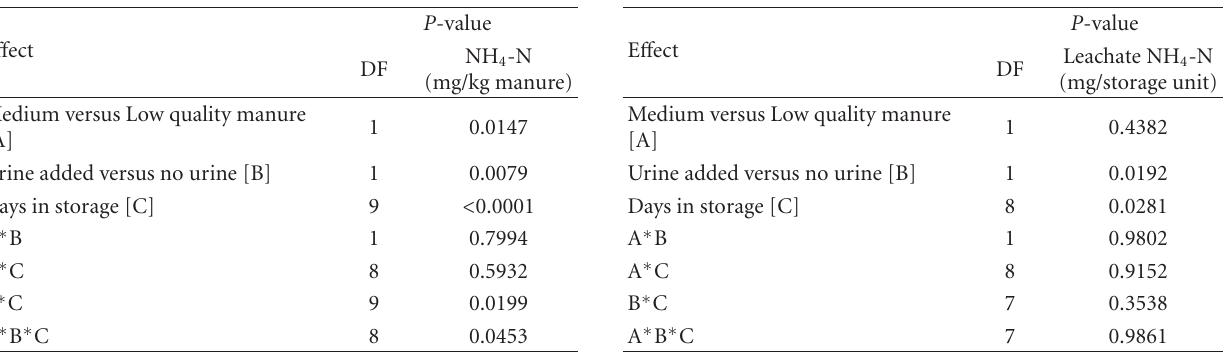
Table 3: ANOVA results for NH 4 -N content (mg NH 4 -N per manure storage unit) of leachate collected from manure in storage in the dry season experiment. Fixed e ff ects are the manure quality (Medium versus Low quality), the presence or absence of urine in the manure, and the number of days the manure was incubated (0, 6, 12, 18, 24, 30, 50, 70, 90, or 120 days). Terms for the interaction between fixed e ff ects are denoted by fixed e ff ects terms separated by an asterisk ( ∗ ). DF represents the degrees of freedom of the